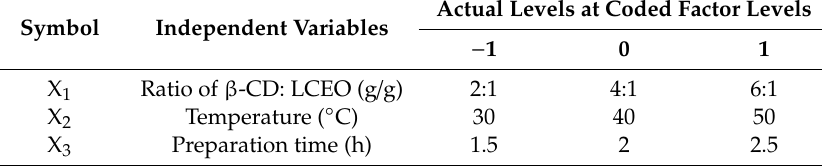
Table 1. Actual levels at coded factor levels of independent variables applied in the response surface methodology